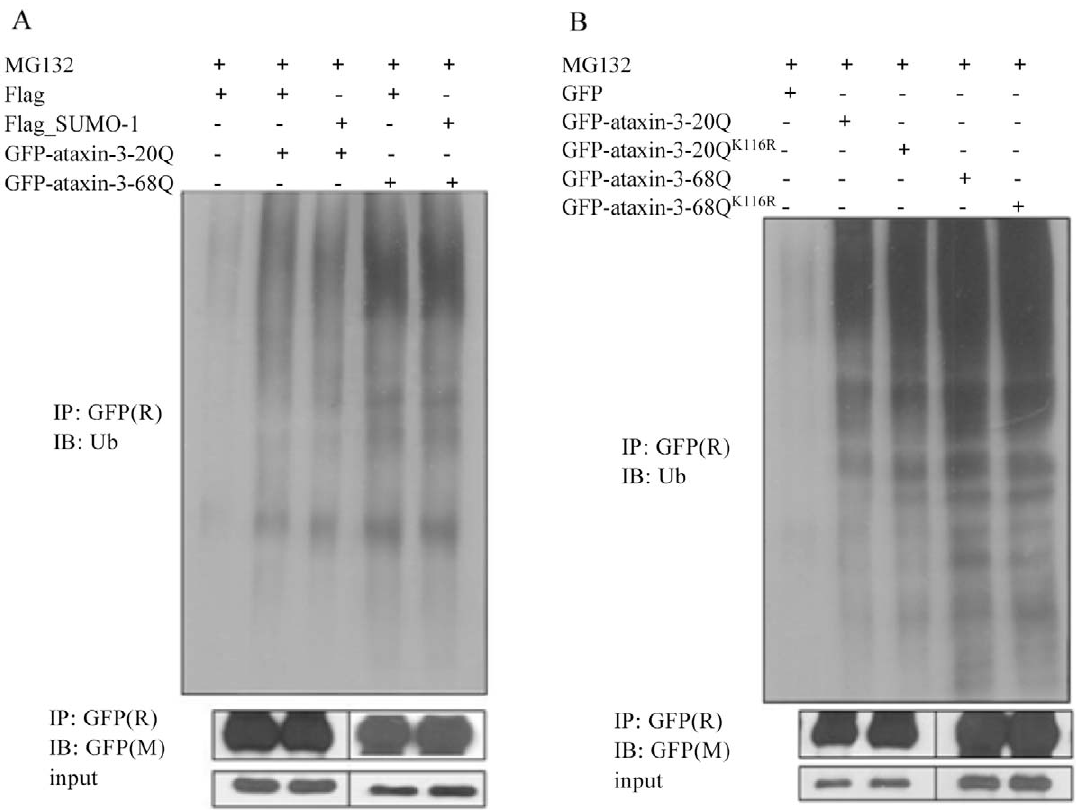
Figure 3. SUMO-1 modification did not affect ataxin-3 ubiquitination. (A) HEK293 cells were co-transfected with GFP-ataxin-3 and Flag- SUMO-1. The cells were treated with 10 m M MG132 for 12 h and subject to immunoprecipitation analysis using rabbit polyclonal antibodies against GFP. The immunoprecipitants were subject to immunoblotting analysis with the indicated antibodies. (B) HEK293 cells were transfected with GFP- ataxin-3 or GFP-ataxin-3 K166R . The cells were treated with 10 m M MG132 for 12 h and subject to immunoprecipitation analysis using rabbit polyclonal antibodies against GFP. The immunoprecipitants were subject to immunoblotting analysis with the indicated antibodies.